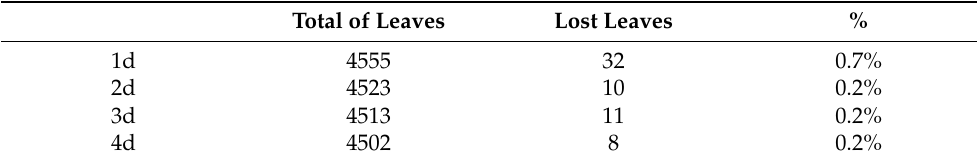
Table 1. Leaf area and lost leaves before and after